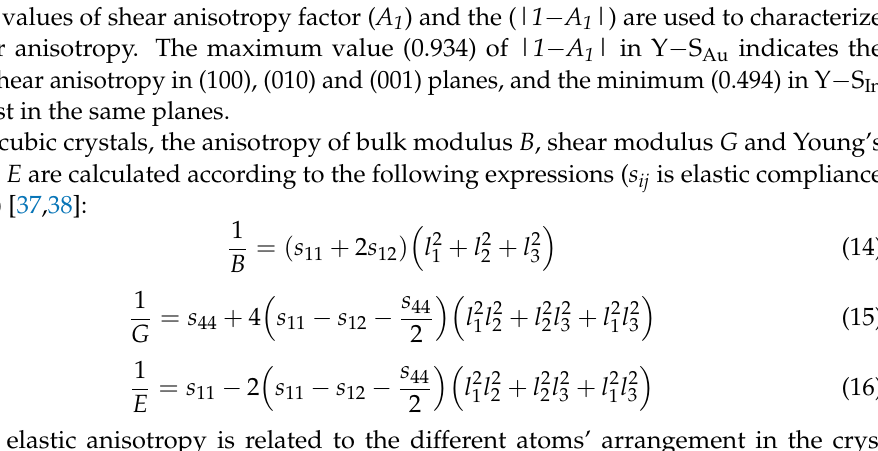
Figure 3. Variation of the elastic anisotropy indices A U , A shear ( a ) and |1 − A 1 | ( b ) of AuIn 2 and doped systems.